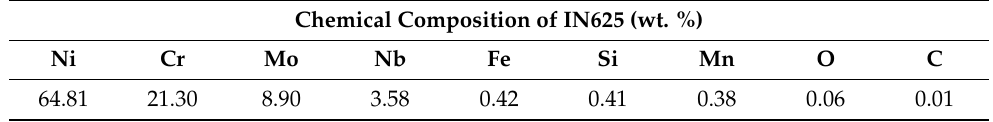
Table 1. Chemical composition of the IN628